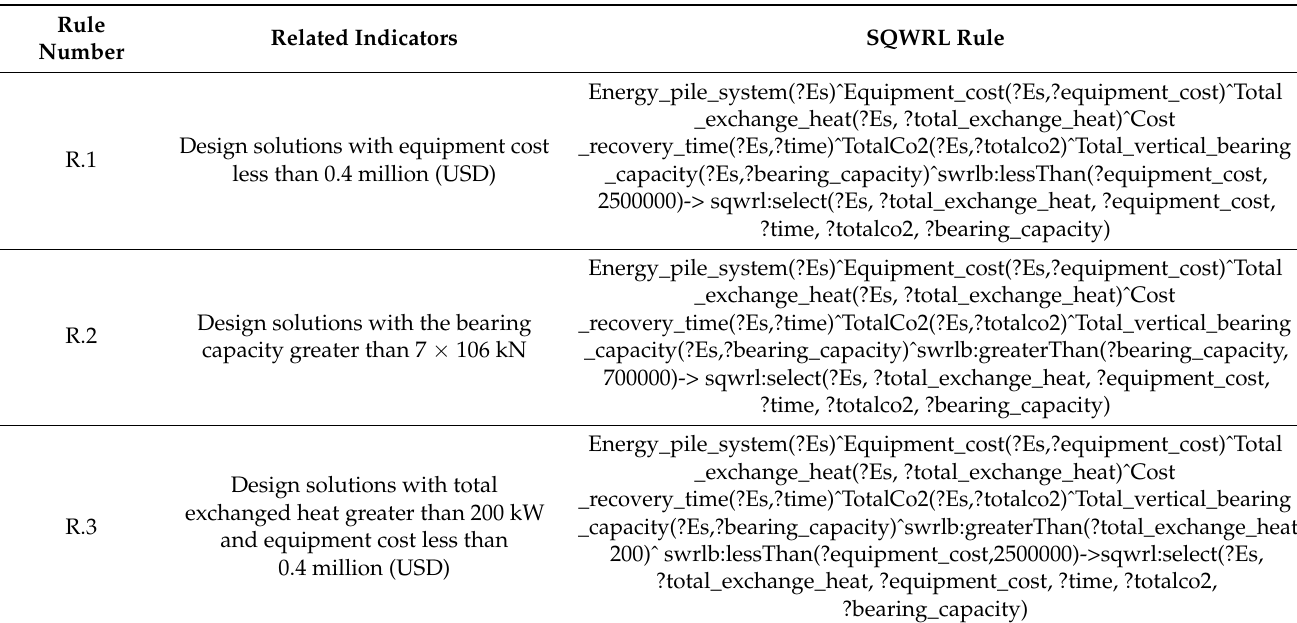
Table 4. SQWRL rules to query related indicators in the case study.